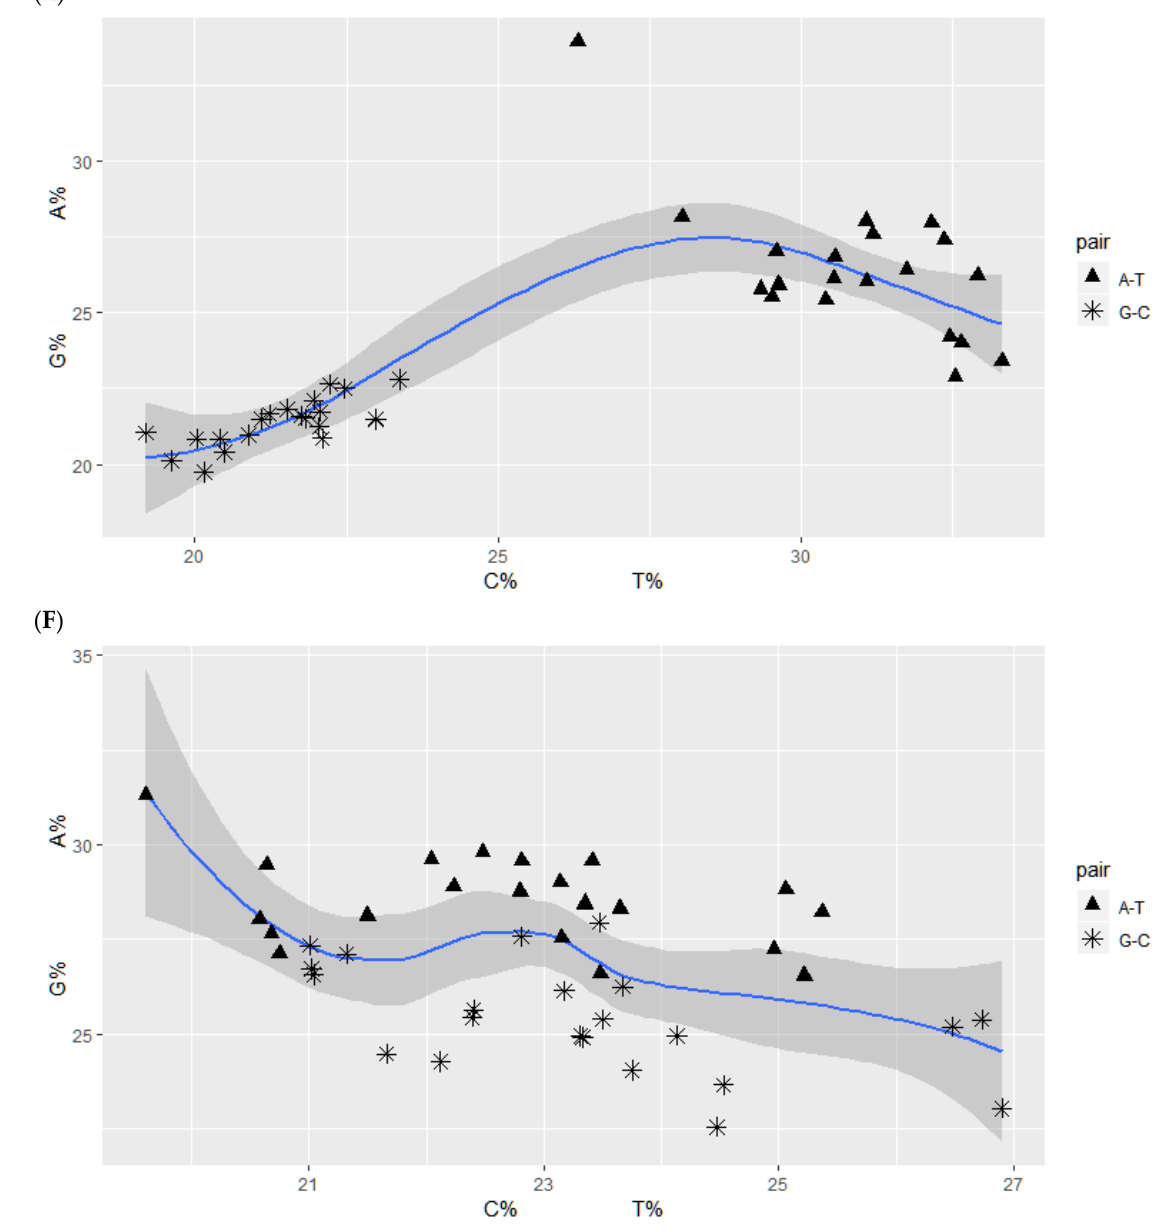
Figure 5. Relative frequencies of nucleotides in complementary base pairs of human chromosomes. Vertical axis: purines A and G; Horizontal axis: complementary pyrimidines T and C. For the case of exactly fulfilled CSPR, the base pairs A-T and G-C lie on a diagonal straight line, f A ≈ f T, f G ≈ f C, in the purine–pyrimidine diagram. Deviations from CSPR cause deviations from diagonality. Numerical values are given in Supplementary Table S1. ( A ) Relative frequencies of complementary nucleotide pairs in human chromosomes. The purine–pyrimidine frequency graph is very close to a typical diagonal straight line of exact CSPR. It is used for comparison with the graphs in Figure 5B–F; Table S7a–c. Confidence interval (0.9996, 0.9999) and Pearson’s product-moment correlation cor value: 0.9998. ( B ) Comparison of relative frequencies of complementary nucleotide pairs in a random sequence of 200,000 bp. A total of 1000 randomly selected 200 bp subsequences from each human chromosome are concatenated. The purine–pyrimidine frequency graph is rather close to a diagonal straight line of exact CSPR. Confidence interval (0.9721, 0.9912) and Pearson's product-moment correlation cor value: 0.9843. ( C ) Comparison of relative frequencies of complementary nucleotide pairs from the coding DNA of each chromosome. Relative frequencies of nucleotides in complementary nucleotides differ rather significantly ( f A ≠ f T, f G ≠ f C), as seen by the wave-like